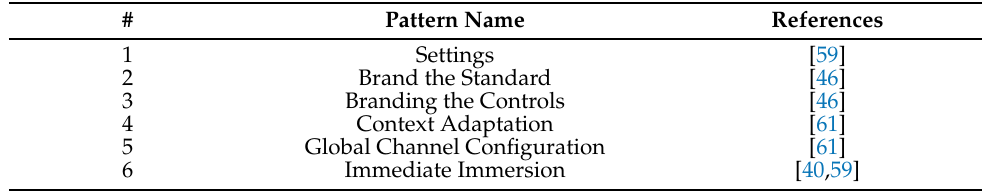
Table 11. Configuration and Customization